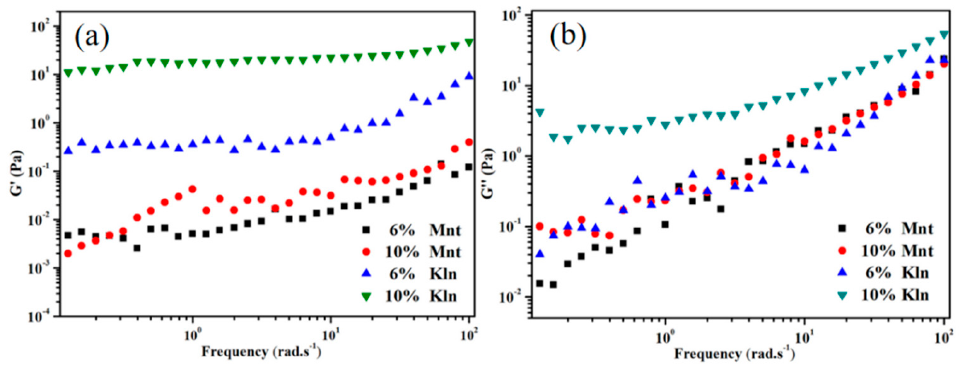
Figure 2. Frequency sweep tests on storage ( a ) and loss moduli ( b ) of four clay–oil dispersions containing 6% and 10% w / w clay in saturates at a 0.03% strain.